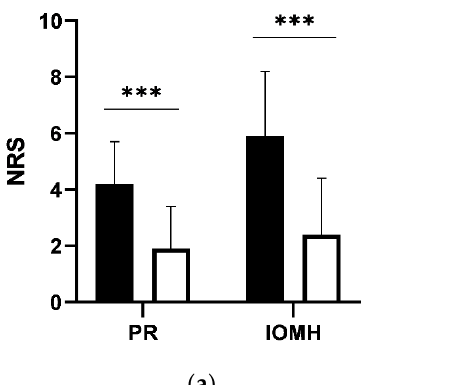
Figure 4. Change in symptoms (pain/radiculopathy scores, PR) and impact on mental health (IOMH) before and after the rehabilitation program ( a ). Comparison between PR and IOMH before and after the study ( b ). (** p < 0.01, *** p < 0.001)